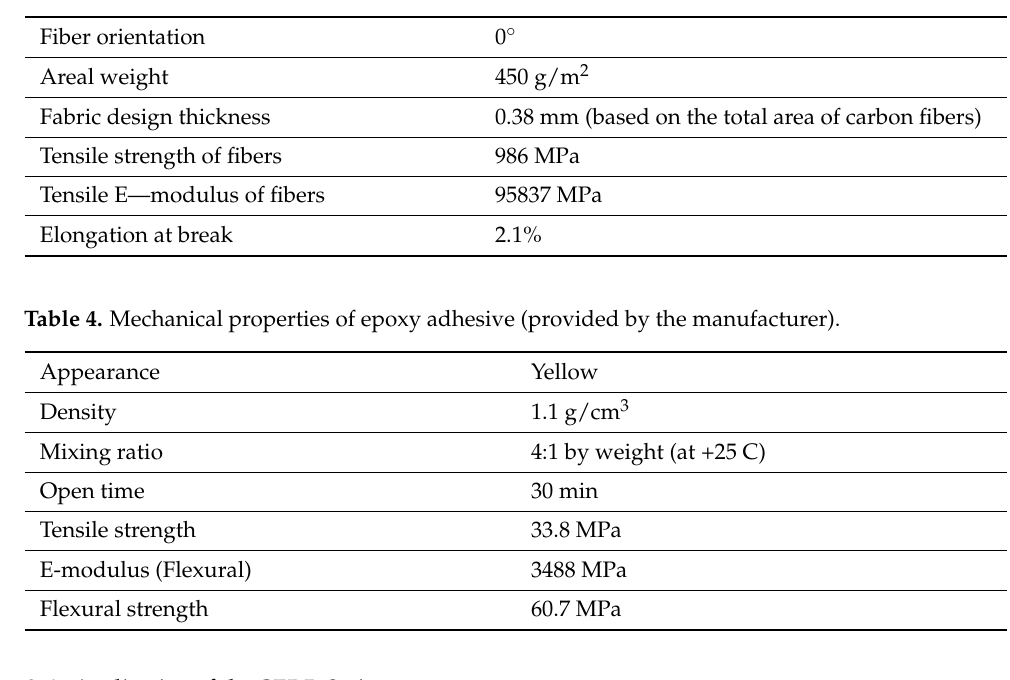
Table 3. Mechanical properties of CFRP strips (provided by the manufacturer).